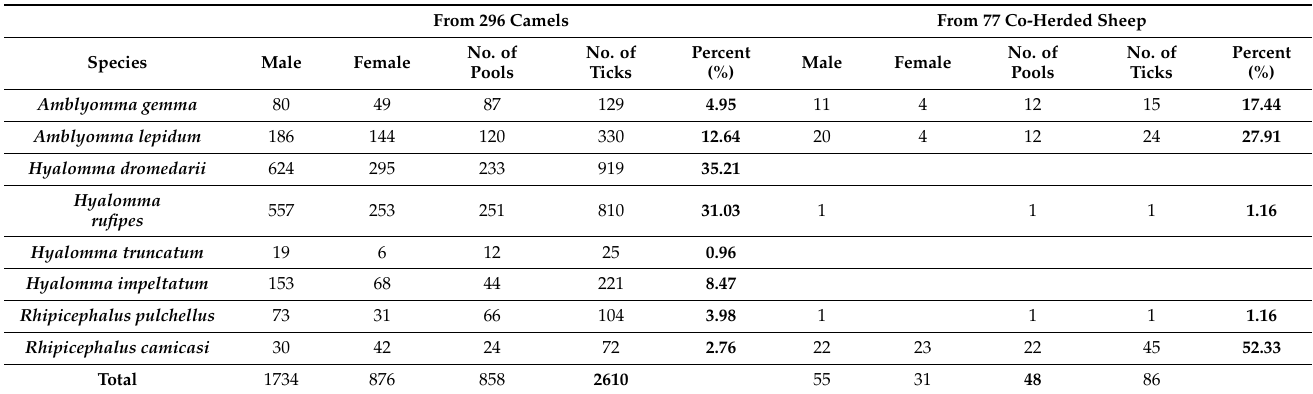
Table 2. Tick species collected from camels and co-herded sheep in Marsabit, Kenya, in February2020 to March 2020. From 296 Camels From 77 Co-Herded Sheep